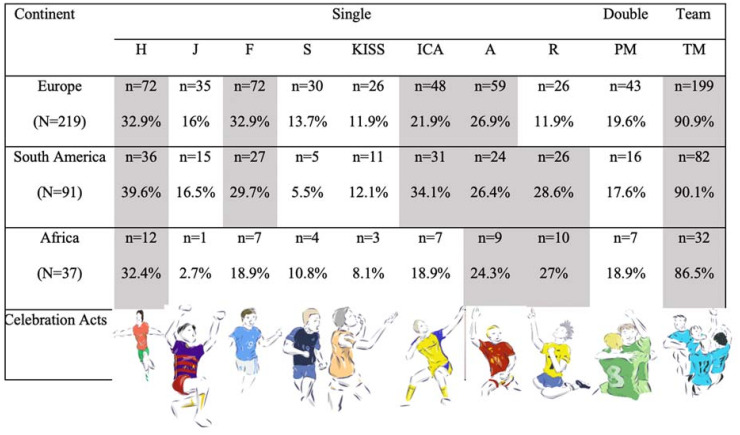
Celebration actions’ frequency by players’ continent origin.